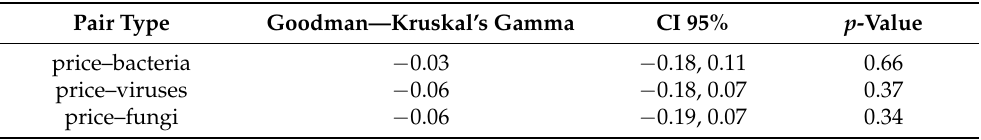
Table 3. Goodman–Kruskal’s gamma statistic for subjective associations between expected microbio- logical threats and market price of smartphone.